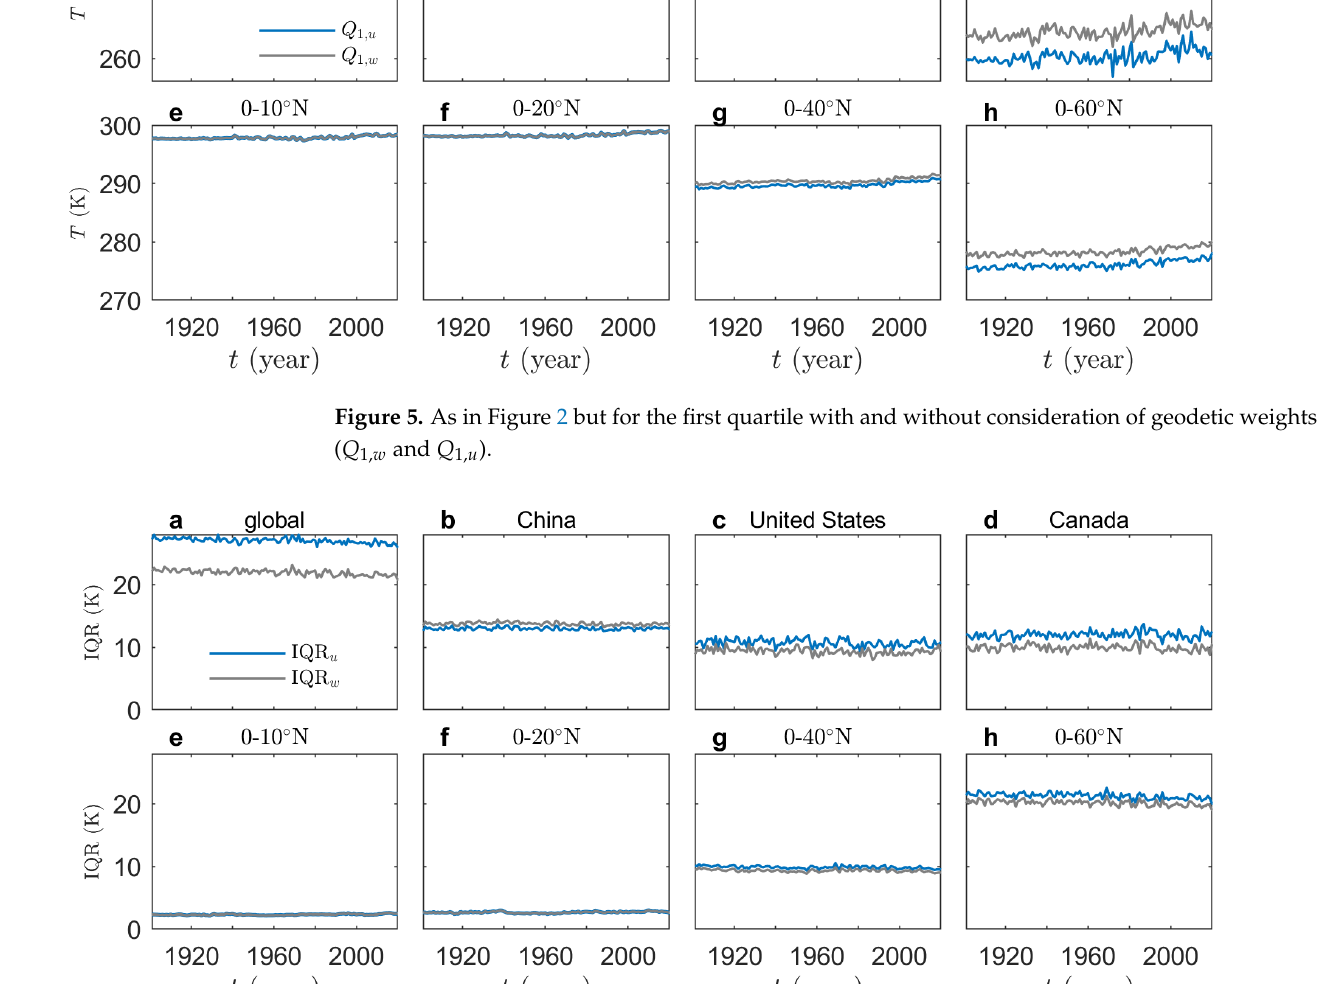
Figure 6. As in Figure 2 but for the interquartile range (IQR) with and without consideration of geodetic weights (IQR w and IQR u